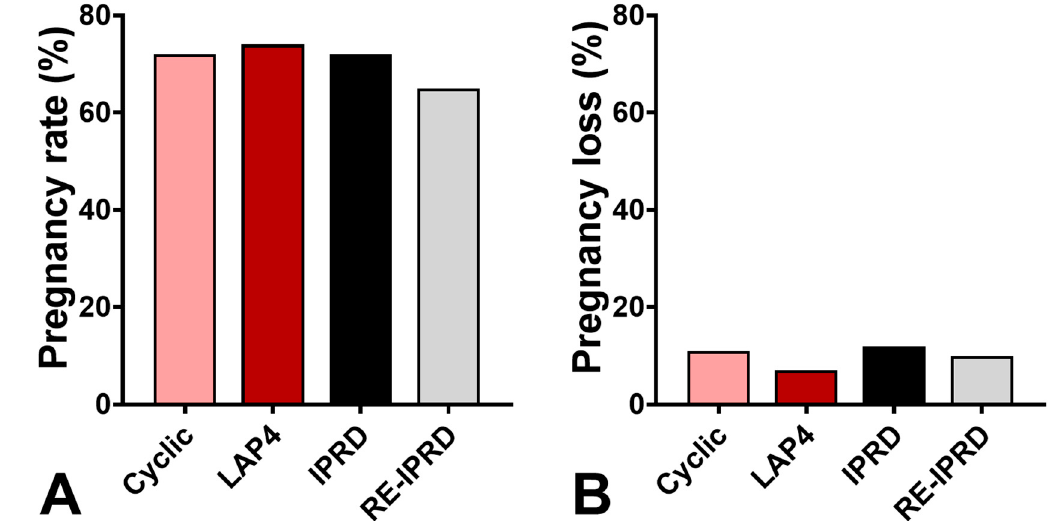
Figure 7. Pregnancy rates ( A ) and pregnancy losses ( B ) up to 60 days of cyclic and acyclic mares synchronized with long-acting progesterone (LAP4) or intravaginal progesterone-releasing device for the first time (IPRD, n = 130) or resynchronized with IPRD (n = 32) between 8 and 15 days after the first synchronization (RE-IPRD). Cyclic (n = 75): mares having ovulation confirmed after induction of ovulation (follicle ≥ 35 mm) with histrelin acetate (250 µ g); LAP4 (n = 92): acyclic mares treated with estradiol-17 β for 3 days and then administered a single dose of long-action progesterone (LAP4, 1.5 g); IPRD (n = 130): acyclic mares treated with estradiol-17 β for 3 days and then given an IPRD containing 1 g of natural progesterone; RE-IPRD: mares not used after 8 days after insertion of an IPRD in the first synchronization were treated 8–15 days later with estradiol-17 β for 3 days and then given a new IPRD. Embryo transfer was performed 4–8 days after ovulation or progesterone treatment and pregnancy diagnosis was performed 5 days later. Once pregnancy was confirmed, mares in the 3 acyclic groups received weekly injections of LAP4 (1.5 g) until 120 days of pregnancy. Mares in IPRD and RE ‐ IPRD groups had the device removed three days after the first PD.